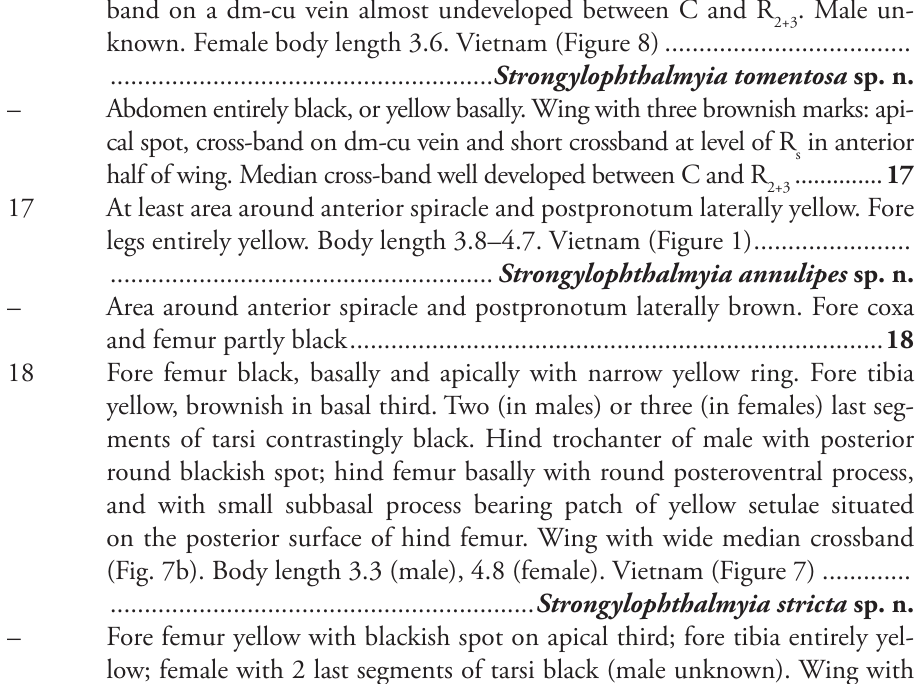
– – Frons black, yellow in anterior third. Basisternum with a pair of yellow spots. Body length 5.5–6.0. Burma. ... Strongylophthalmyia humeralis Frey, 1956 15 Wing: median transverse band between C and R undeveloped; apical spot 2+3 large, extended from beginning of R vein; short cross-band at level of R 2+3 s undeveloped. Face yellow, arista yellow. Body length 5.0 (male), 6.0 (female). China (Zhejiang) ..... Strongylophthalmyia bifasciata Yang & Wang, 1992 – Wing median transverse band between C and R well-developed, reaching 2+3 costal margin; apical spot small, its length equal distance from this spot to R vein; short cross-band at a level of R in anterior half of wing developed. 2+3 s Face black, arista dark brown. Male unknown. Female body length 5.0. Chi- na (Guangxi) ............ Strongylophthalmyia yaoshana Yang & Wang, 1998 16 Abdomen black, broadly yellow basally, tergite six with lateral yellow spots extending from anterior margin to two thirds of its length. Wing with two brownish marks: short cross-band at a level of R undeveloped; median cross- s band on a dm-cu vein almost undeveloped between C and R . Male un- 2+3 known. Female body length 3.6. Vietnam (Figure 8) .................................... – Abdomen entirely black, or yellow basally. Wing with three brownish marks: api- cal spot, cross-band on dm-cu vein and short crossband at level of R in anterior s half of wing. Median cross-band well developed between C and R .............. 17 2+3 17 At least area around anterior spiracle and postpronotum laterally yellow. Fore legs entirely yellow. Body length 3.8–4.7. Vietnam (Figure 1) ....................... – Area around anterior spiracle and postpronotum laterally brown. Fore coxa and femur partly black .............................................................................. 18 18 Fore femur black, basally and apically with narrow yellow ring. Fore tibia yellow, brownish in basal third. Two (in males) or three (in females) last seg- ments of tarsi contrastingly black. Hind trochanter of male with posterior round blackish spot; hind femur basally with round posteroventral process, and with small subbasal process bearing patch of yellow setulae situated on the posterior surface of hind femur. Wing with wide median crossband (Fig. 7b). Body length 3.3 (male), 4.8 (female). Vietnam (Figure 7) ............. – Fore femur yellow with blackish spot on apical third; fore tibia entirely yel- low; female with 2 last segments of tarsi black (male unknown). Wing